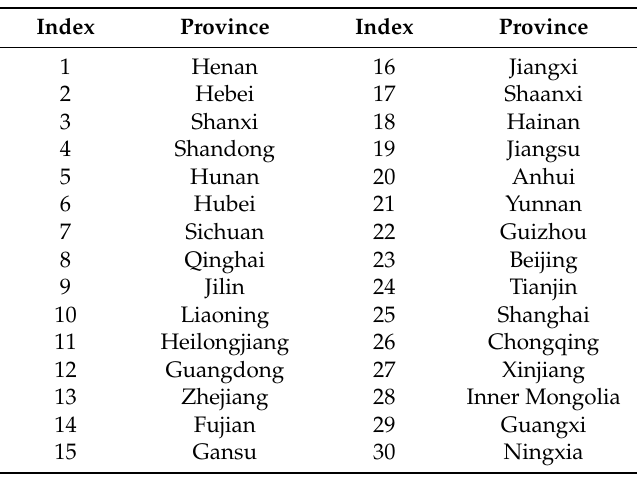
Table 3. Indices for 30 districts.